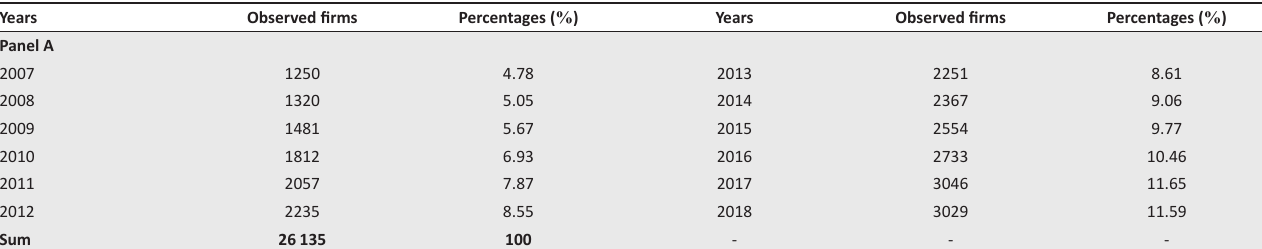
TABLE 5a: Sample distribution by years and industrial sectors. Years